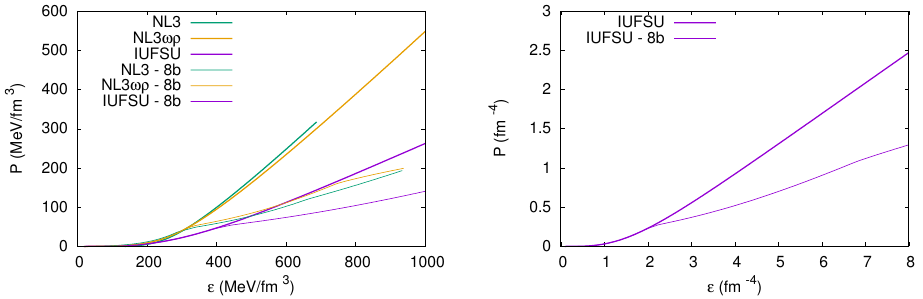
Figure 9. ( Left ) Stellar matter EOS obtained with different parametrizations. Thick solid lines show EOS with nucleons only and thin lines represent EOS with the eight lightest baryons and ( right ) the same EOS for IUFSU with and without hyperons but with different units for pressure and energy density.